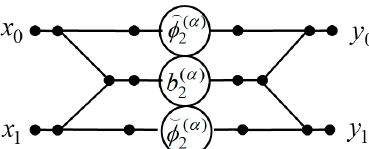
Figure 1. The data flow structure of the proposed algorithm for the computation of the two-point DFrFT.